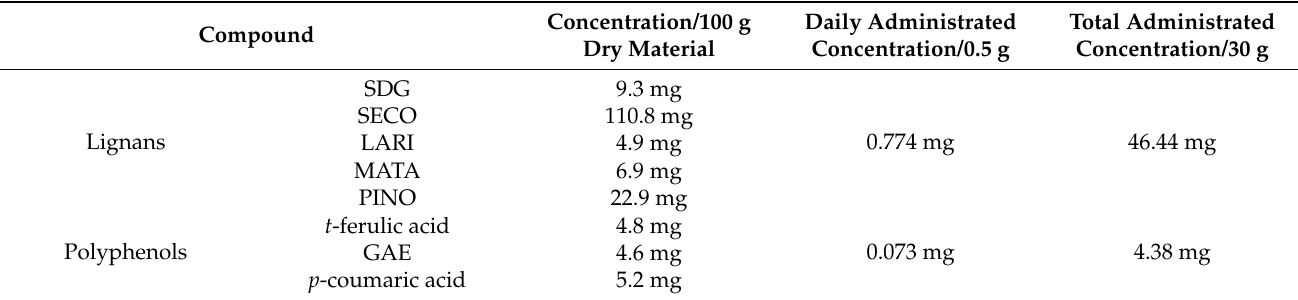
Figure 1. Flaxseed extraction and HPLC/TOF-MS analysis study on HPLC Agilent 1200 Series connected with Agilent 6520 Series Q-TOF-MS electrospray ion source in negative mode. Table 1. Quantitative calculation of lignans and phenolic fractions from flaxseed extract.